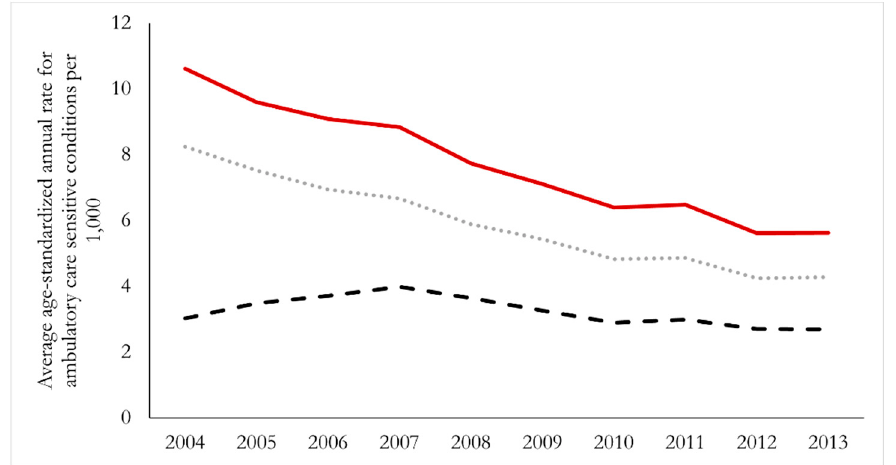
Figure 2. Trends in age-standardized annual rates of hospitalization, incidence of hospitalization, and ambulance arrival for ambulatory care sensitive conditions among those 74 years of age and younger in New Brunswick, 2004–2013. Dash—ambulance arrival rate, Dots—hospitalization incidence, solid line—hospitalizations.